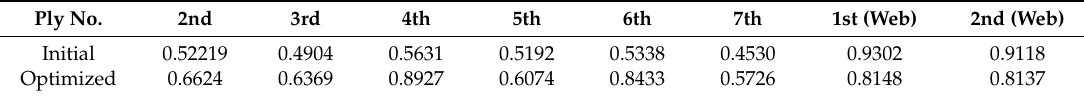
Table 4. Maximum Tsai-Wu failure factors of